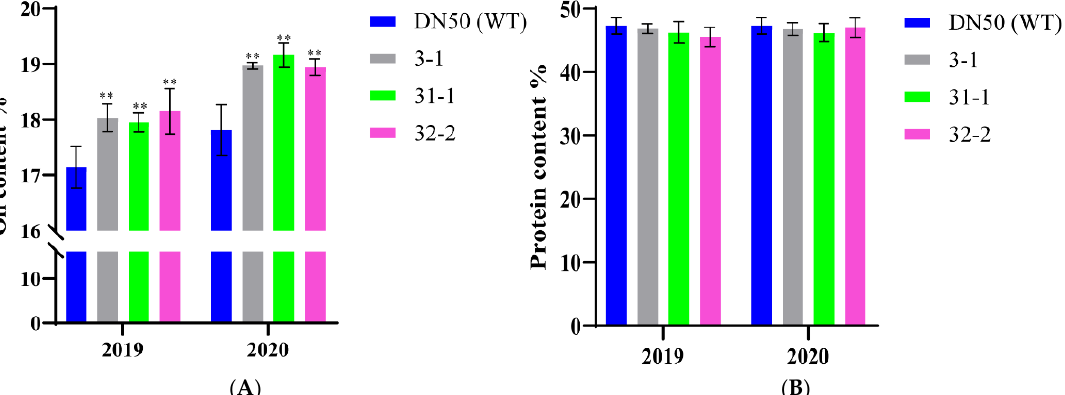
Figure 7. Seed oil contents ( A ) and seed protein contents ( B ) of three GmWRI1a-OE lines and wild- type DN50 over 2 seasons. The data represent the means ± SD of three replicate experiments, and the values are in dry weight (DW) for seeds, ** indicate significant differences compared with the wild type at p < 0.01, respectively, as determined by one-way analysis of variance (ANOVA). To verify whether overexpression of GmWRI1a affects the fatty acid composition, the major fatty acid composition in seeds between the GmWRI1a-OE lines and WT plants were compared. A significant increase in linoleic acid (C18:2) content ( p < 0.01) and a sig- nificant decrease in palmitic acid (C16:0) content ( p < 0.01) were observed in seeds of the